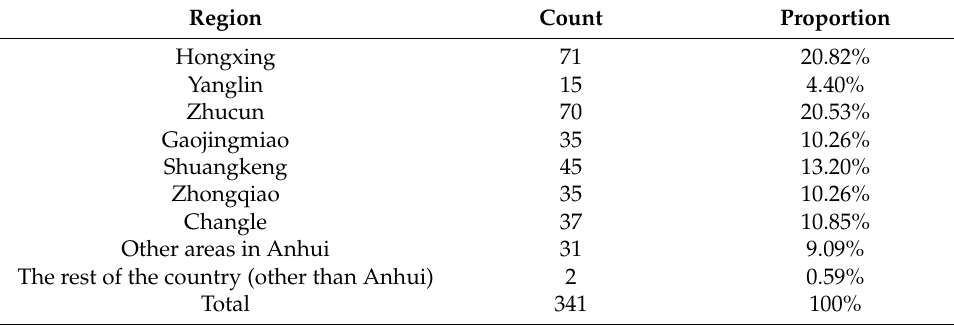
Table 2. Sources of sample